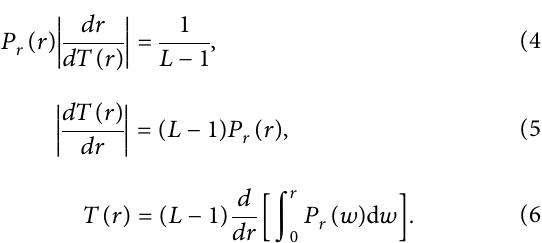
Figure 2: Arbitrary PDF.